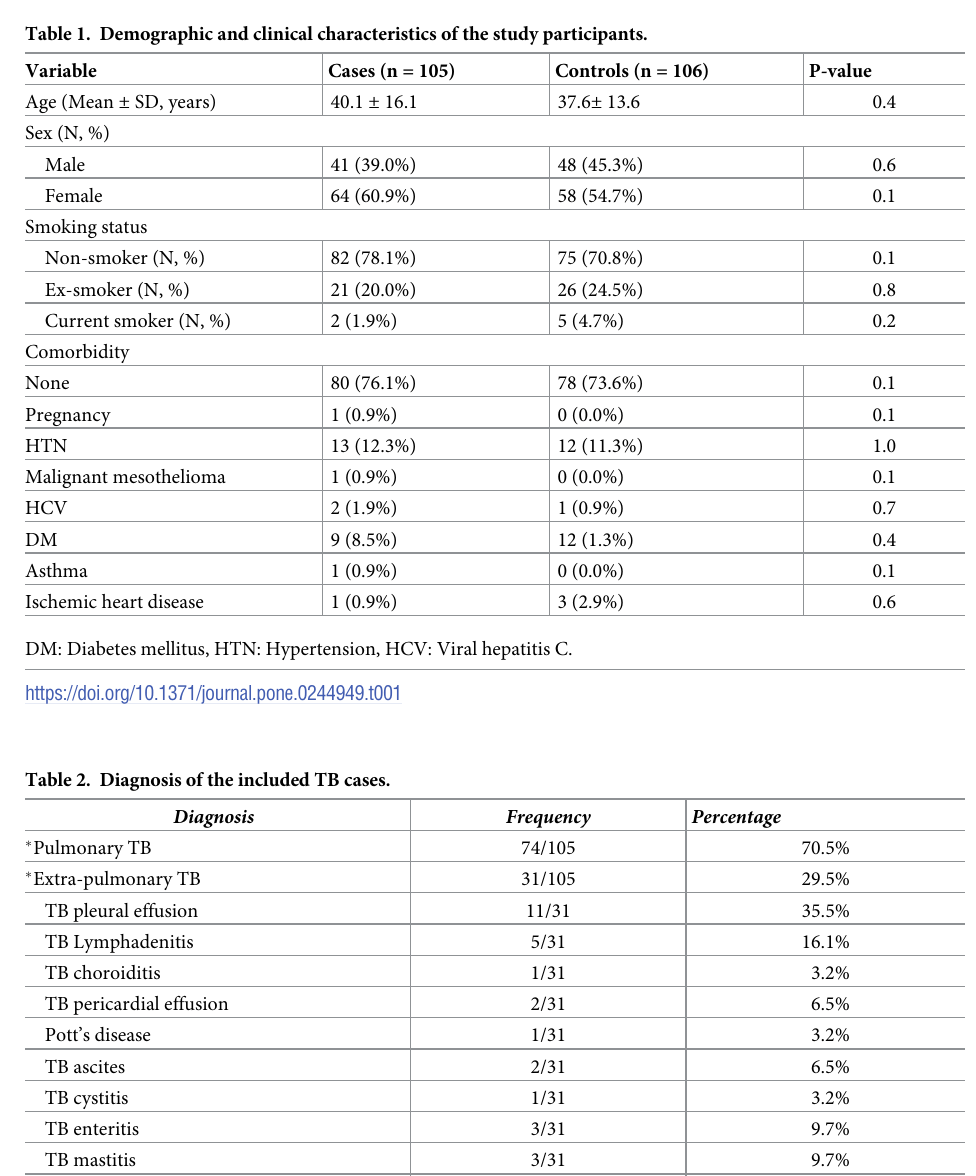
age of 37.65 ± 13.6. There were non-significant differences regarding demographic and clinical characteristics of the study participants as illustrated in Table 1. Pulmonary and extra pulmo- nary TB represented 70.5% and 29.5%, respectively, of the enrolled cases as shown in Table 2.